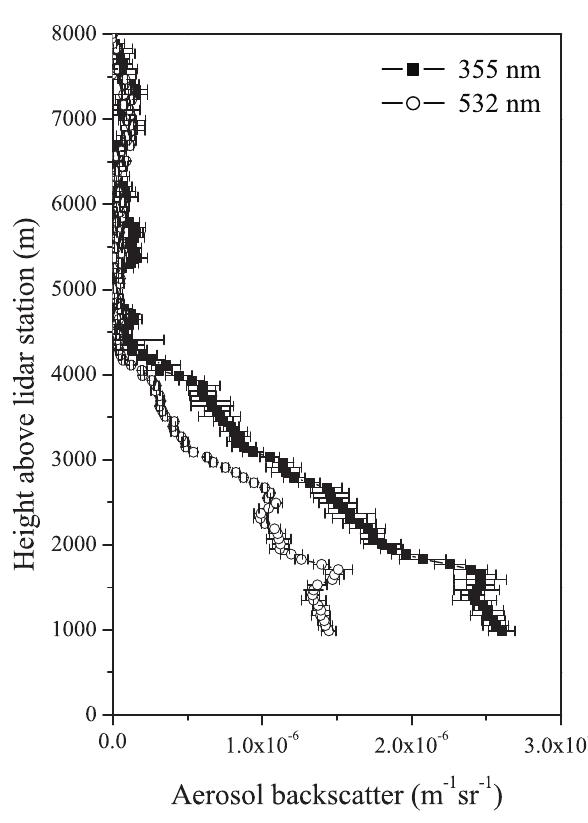
Fig. 3a,b. Vertical profi les of the aerosol backscatter (solid squares) and extinction (open squares) at 355 nm (a), vertical profi le of the lidar ratio at 355 nm (b); Tito Scalo, 16 October 2000 (18:46 - 19:05 UTC).